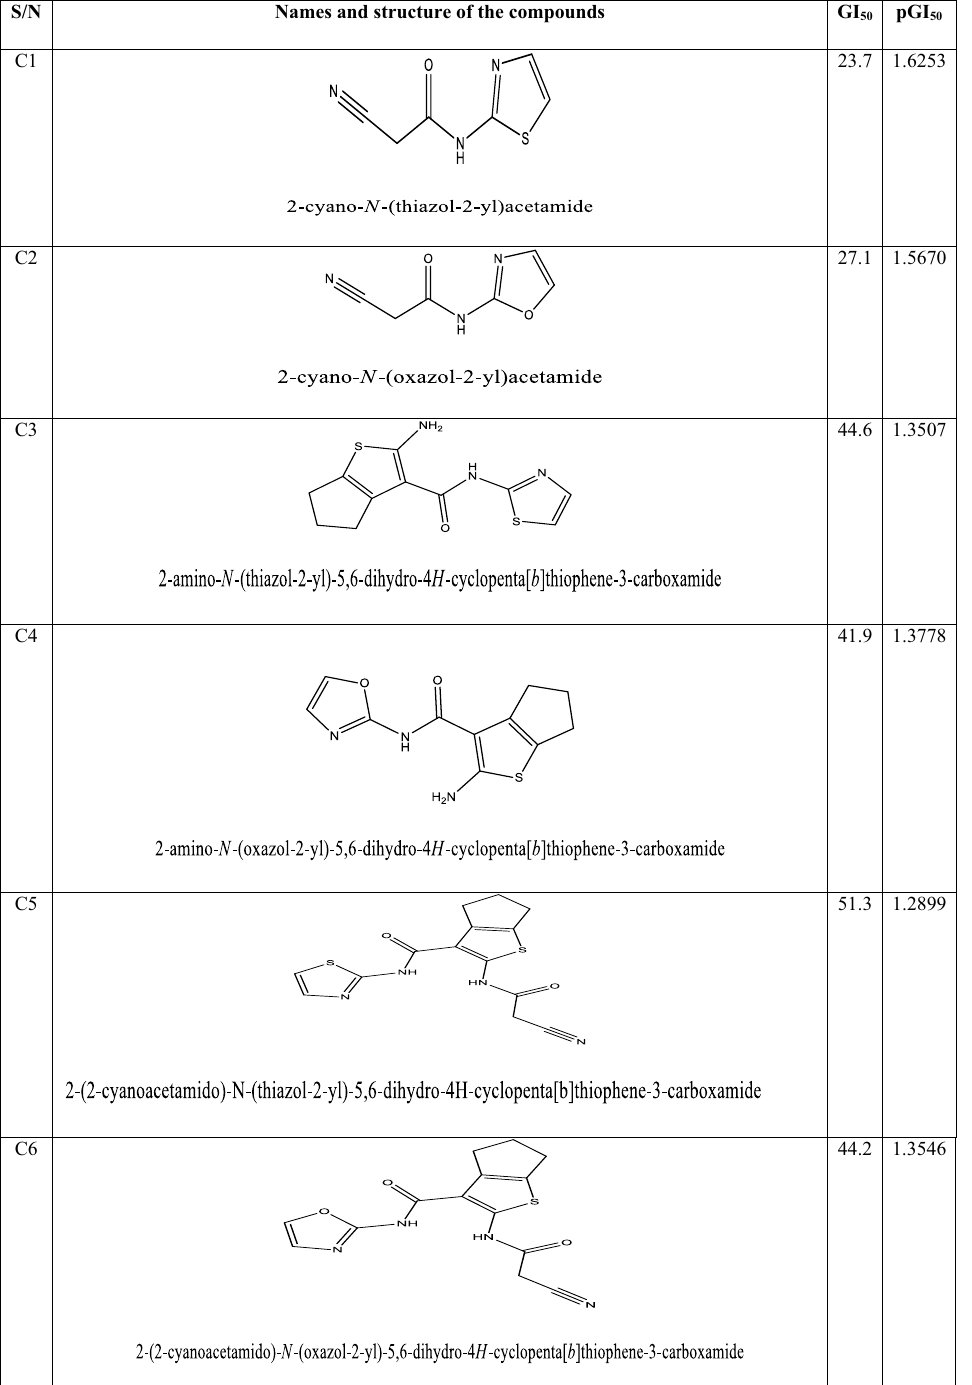
Table 1 2D structure and names of the dataset and their 50% growth inhibitory activities in mmol L − 1 S/N Names and structure of the